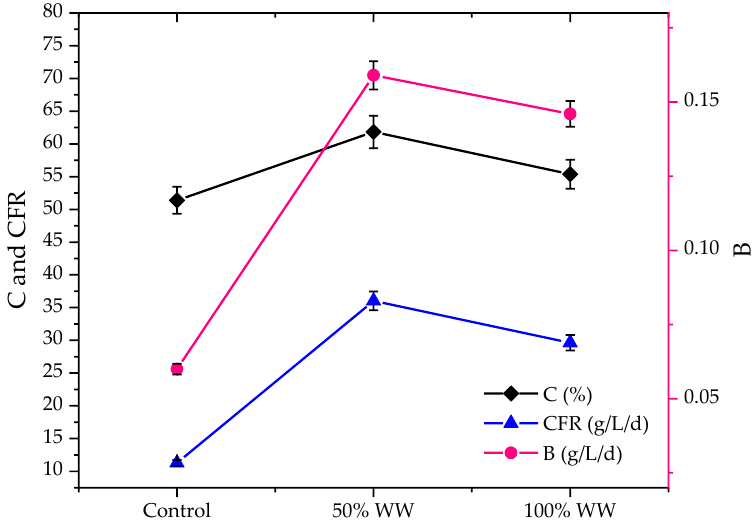
Figure 3. CO 2 fixation rate (CFR), carbon content (%) and biomass productivity (B: g/L/d) of C. vulgaris cultivated in different concentrations of mushroom farm wastewater (WW: wastewater).